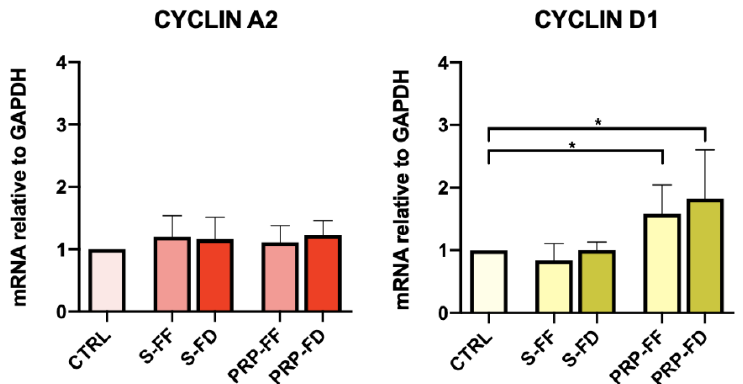
Figure 5. Cyclin A2 and Cyclin D1 mRNA levels in MIO-M1 cells post-scratch assay at 48 h. Gene expression analysis of the proliferation markers Cyclin A2 and Cyclin D1 was performed using Real-Time PCR. Results are reported as the fold changes relative to untreated MIO-M1 cells cultured in DMEM L-Glutamax plus 5% FBS and represented as the mean ± standard deviation. Experiments were performed in triplicate. Statistical analyses were performed using one-way ANOVA followed by Tukey’s multiple comparisons test. *, p < 0.05.